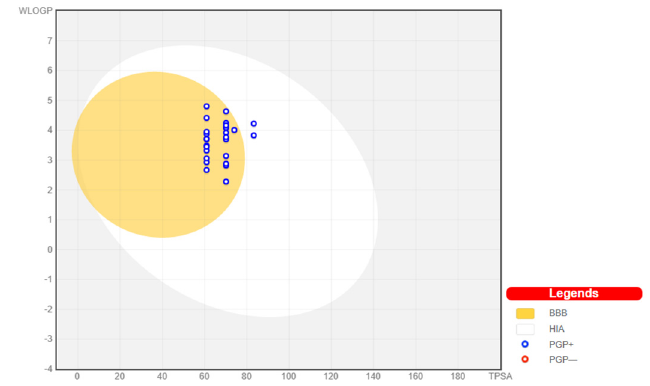
Figure 8. BOILED-Egg diagram of the tested compounds.